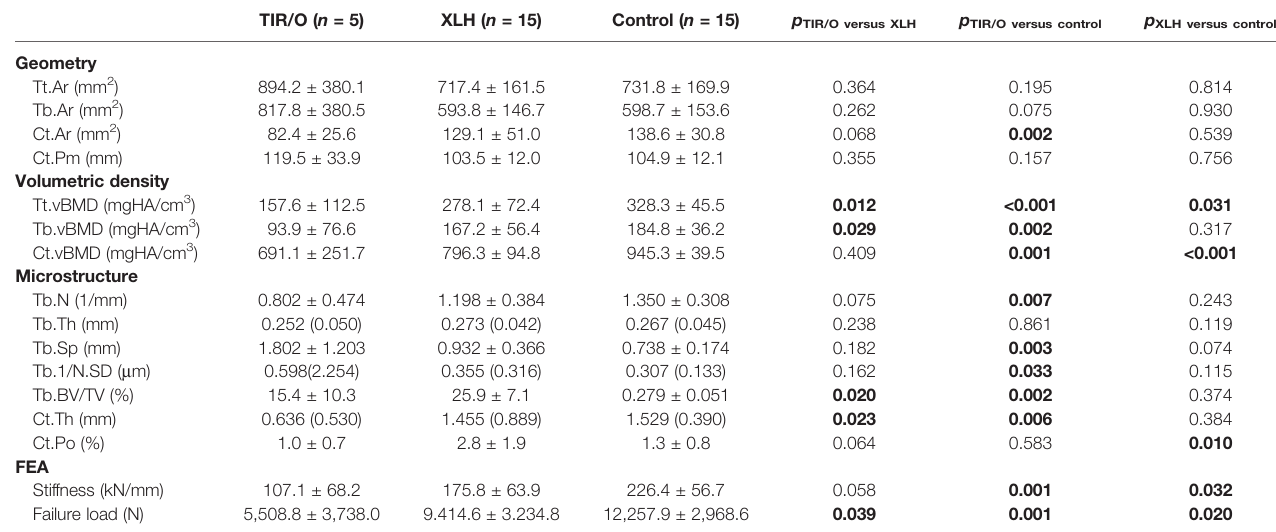
TABLE 3 | Comparison of HR-pQCT measurements and estimated bone strength at the distal tibia. TIR/O ( n = 5) XLH ( n = 15) Control ( n = 15) p TIR/O versus XLH p TIR/O versus control p XLH versus